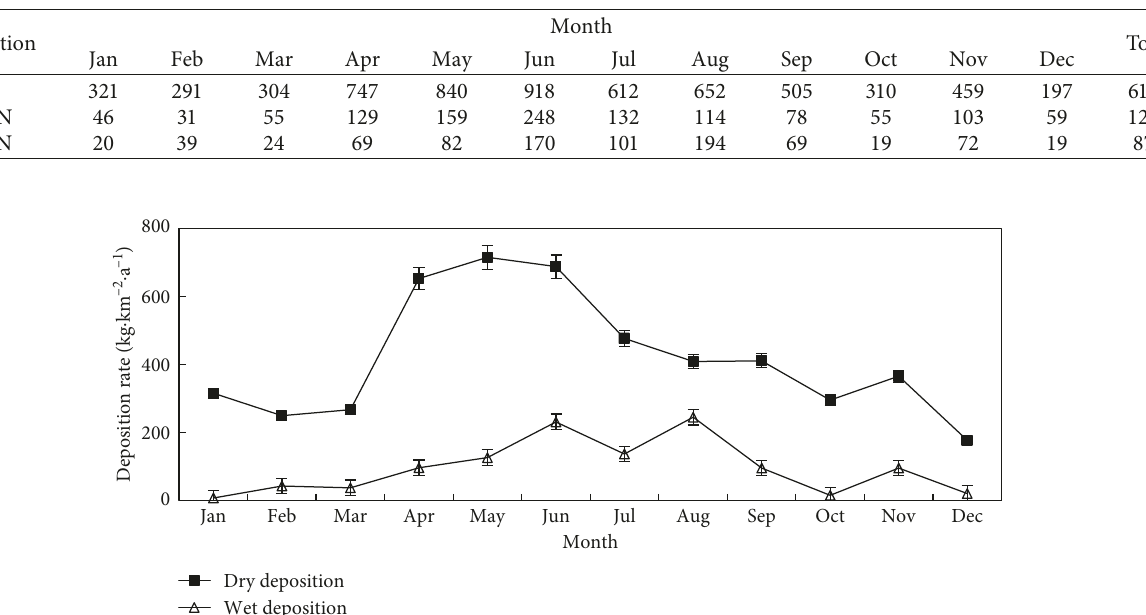
Figure 2: Seasonal variations in N deposition flux around the Taihu